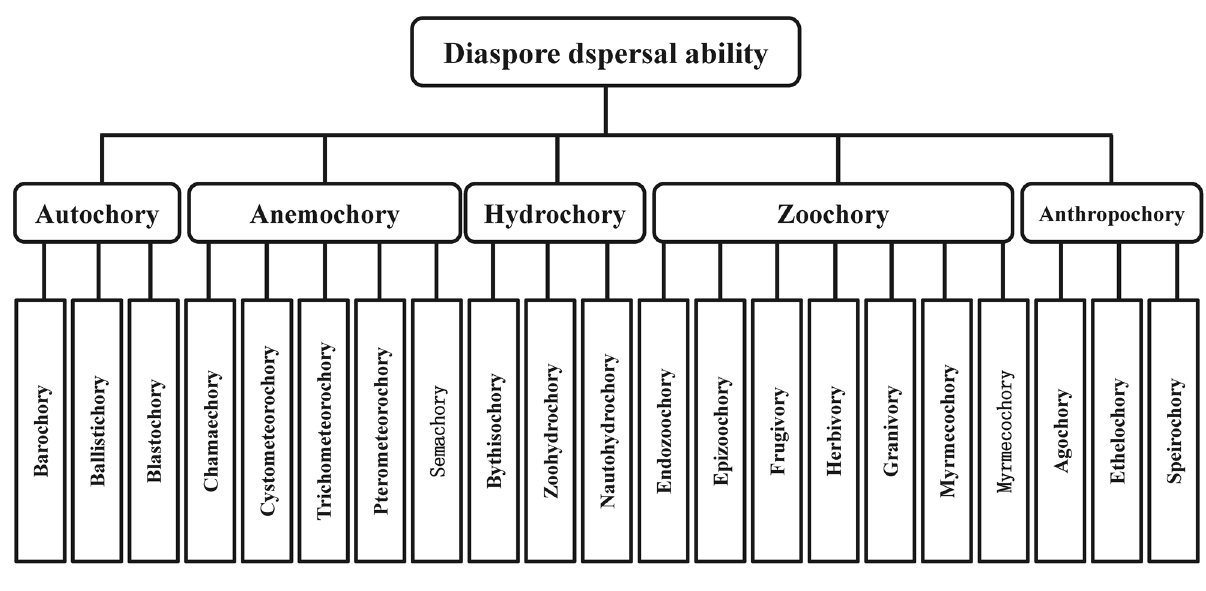
Figure 1. Five dispersal strategies with twenty-one dispersal